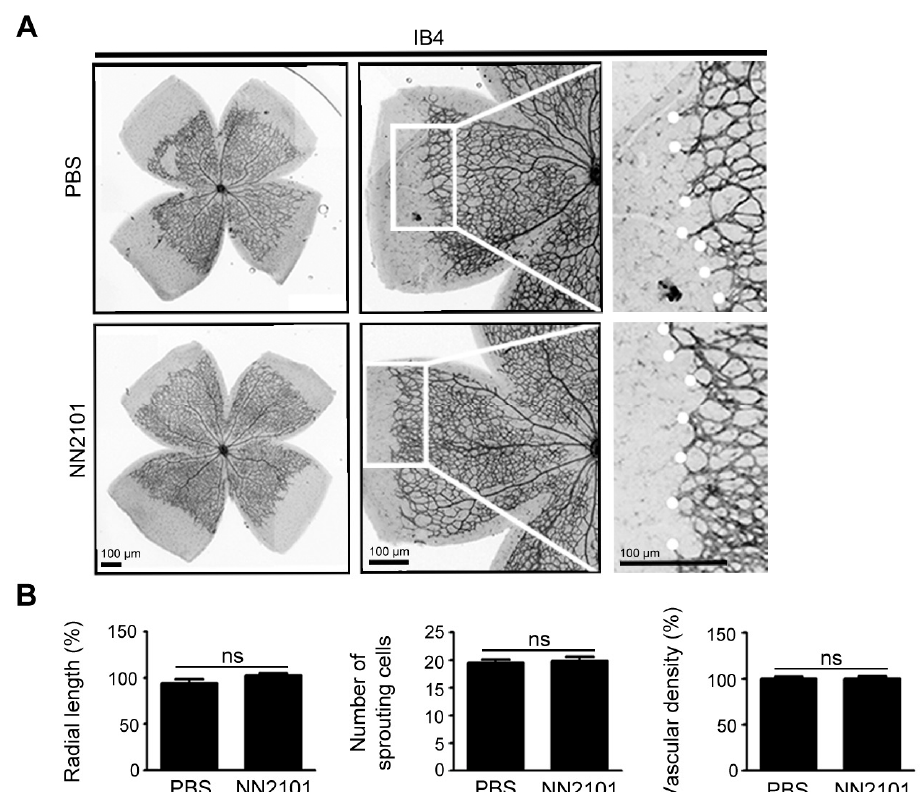
Figure 5. NN2101 does not affect early retinal vascular development in mice. ( A ) representative images of retina vasculature of mice that received an intravitreal injection of NN2101 (20 μ g) or PBS at postnatal day (P) 2. Mice were maintained under normoxia until P6, and the retinal vasculature was visualized by staining with IB4 (black). High-magnification views of the growth fronts of vessels are shown on the right and vascular sprouts are marked with white dots. Scale bars = 100 μ m; ( B ) quantification of the radial length of blood vessels, number of sprouting endothelial cells, and vascular density in the whole-mounted retinas of mice in ( A ). The data are shown as the mean ± SEM (unpaired Student’s t -test, ns = not significant, n = 4 mice per group).